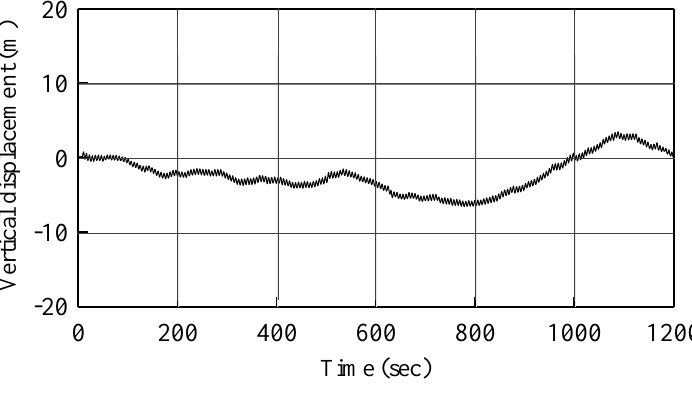
Figure 8 . Vertical displacement derived from vertical velocity integration (T = 6 s).